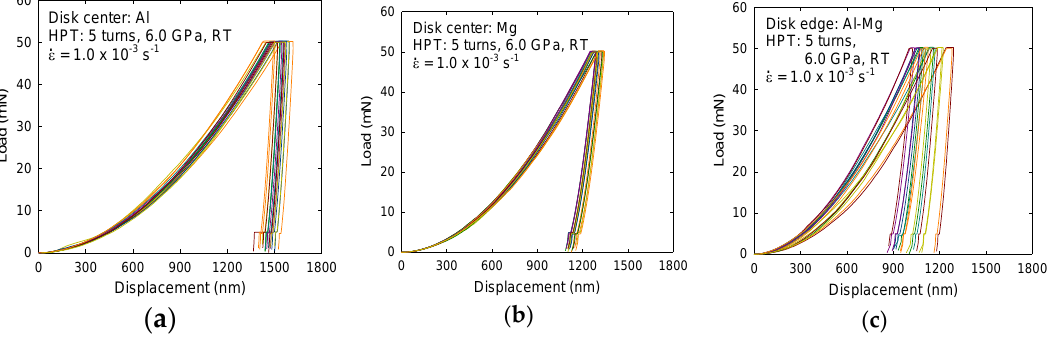
Figure 5. Representative load-displacement curves for ( a ) Al and ( b ) Mg phases at the disk center and for ( c ) the Al-Mg system forming an MMNC at the disk edge when testing at 1.0 × 10 − 3 s − 1 for the sample after five turns by HPT [42].